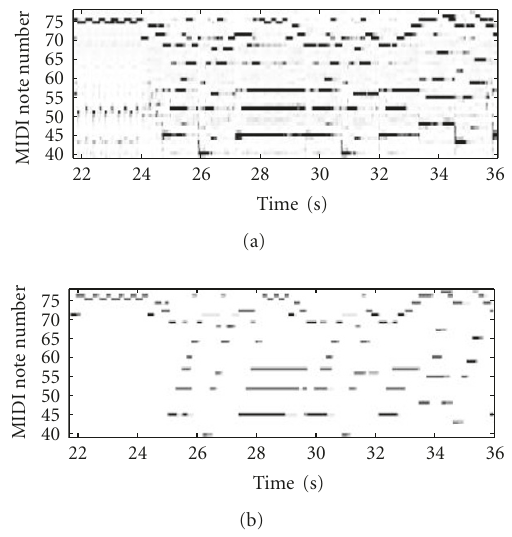
Figure 3: Variation of classification accuracy with the total number of excerpts included, compared to sampling the same total number of frames from all excerpts pooled.